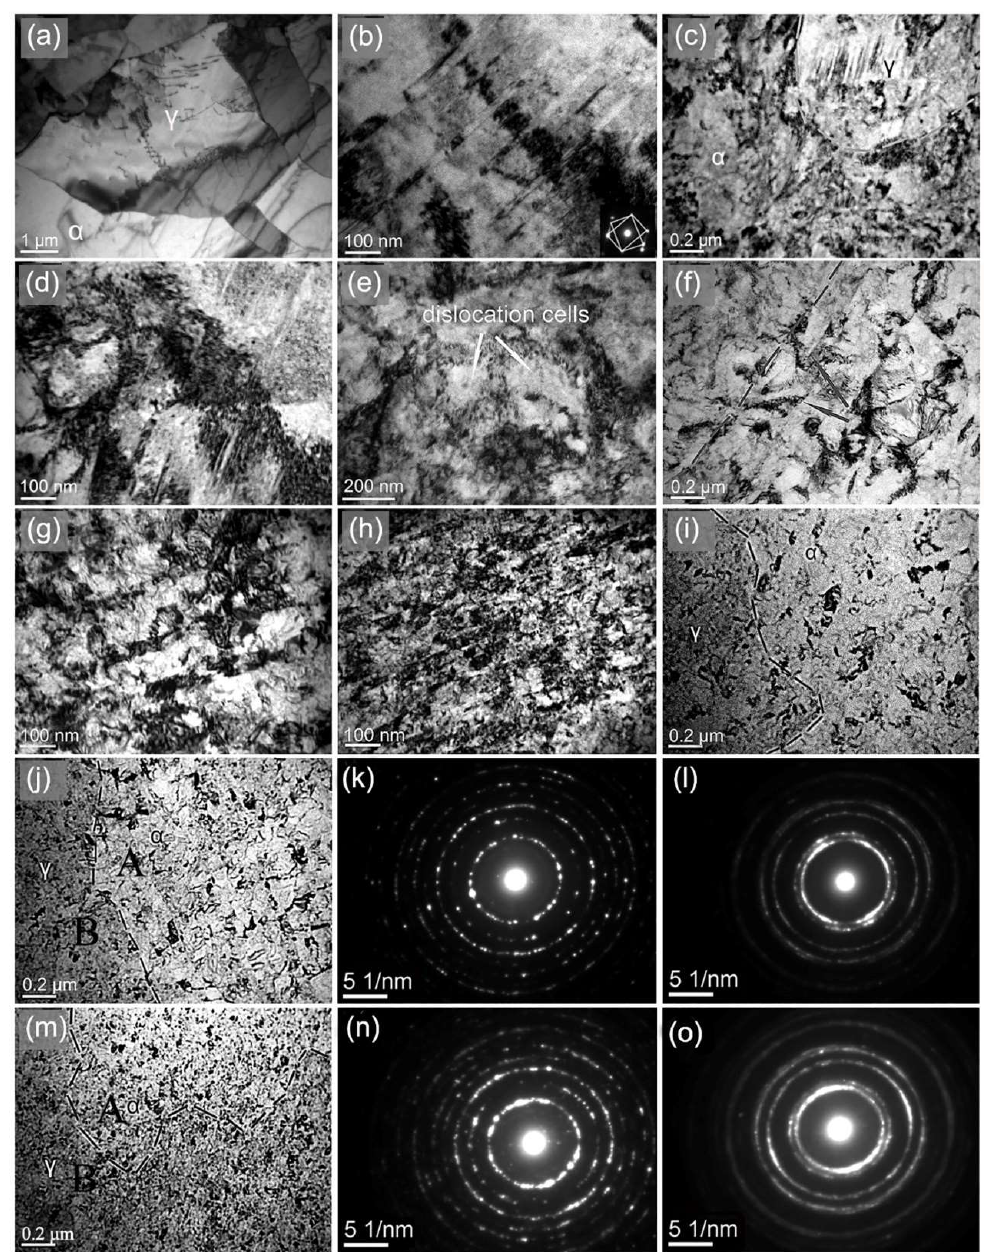
Figure 4. TEM images at the edge of specimens before and after different numbers of revolutions: ( a ) the as-received material; ( b ) 1/4 revolution, austenite; ( c ) 1/2 revolution, austenite and ferrite; ( d ) 1/2 revolution, austenite; ( e ) 1/2 revolution, ferrite; ( f , g ) 1 revolution, austenite at two different magnifications; ( h ) 5 revolutions, austenite; ( i ) 5 revolutions, austenite and ferrite; ( j ) 10 revolutions, austenite and ferrite; ( k ) electron diffraction pattern from region A in Figure 4j; ( l ) electron diffraction pattern from region B in Figure 4j; ( m ) 20 revolutions, austenite and ferrite; ( n ) electron diffraction pattern from region A in Figure 4m; ( o ) electron diffraction pattern from region B in Figure 4m.